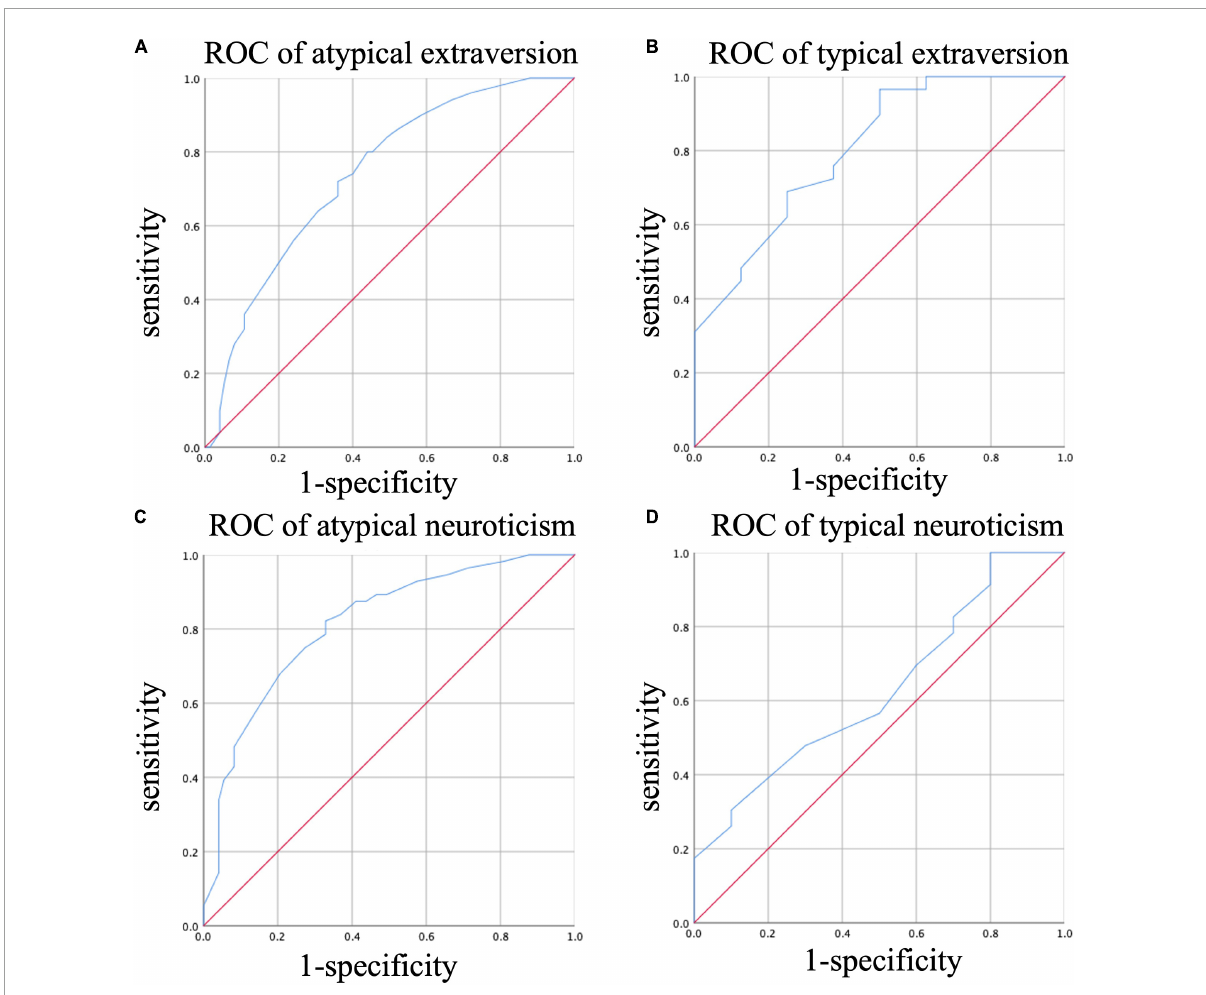
FIGURE3 ROC of HCL-32 for different diagnosis in different personality traits. (A) ROC analysis of the ability of HCL-32 to discriminate between MDD and BD in atypical extraversion group; (B) ROC analysis of the ability of HCL-32 to discriminate between MDD and BD in typical extraversion group; (C) ROC analysis of the ability of HCL-32 to discriminate between MDD and BD in atypical neuroticism group; (D) ROC analysis of the ability of HCL-32 to discriminate between MDD and BD in typical neuroticism